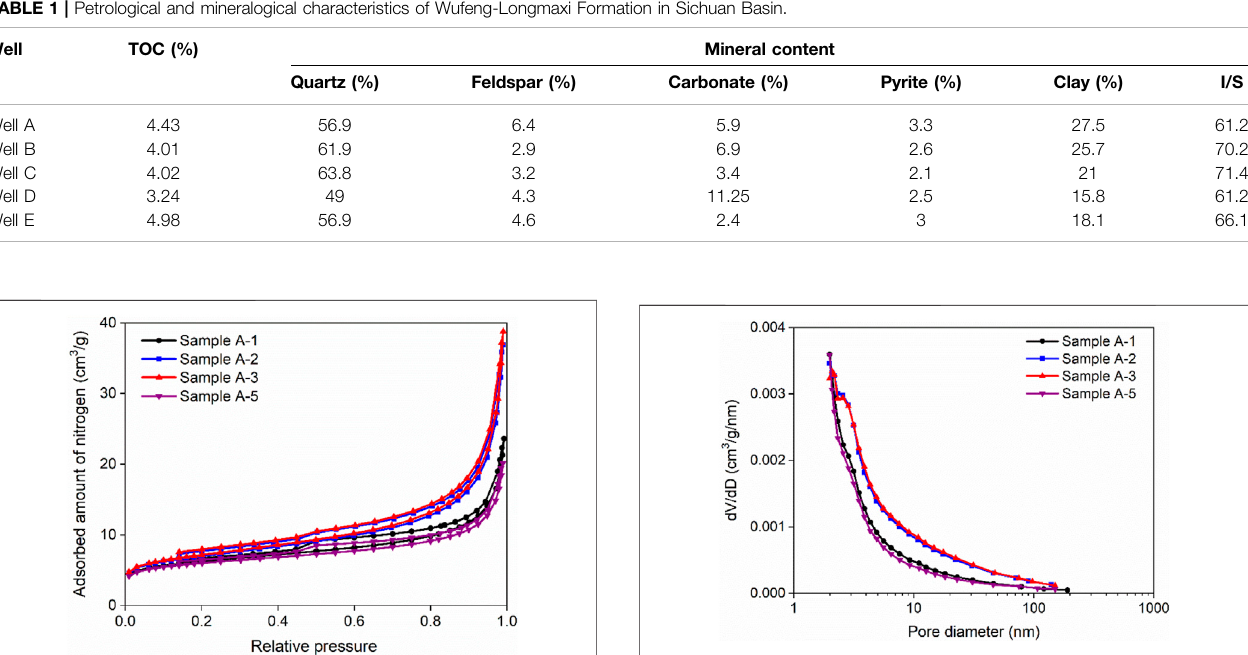
Frontiers in Earth Science |